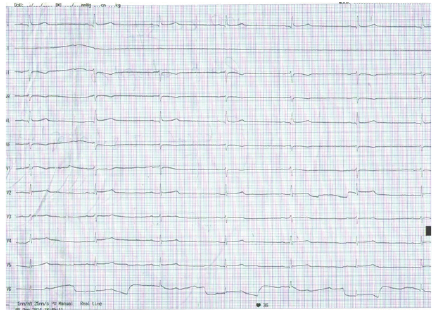
Figure 1: Sinus bradycardia without signs of ischemia on